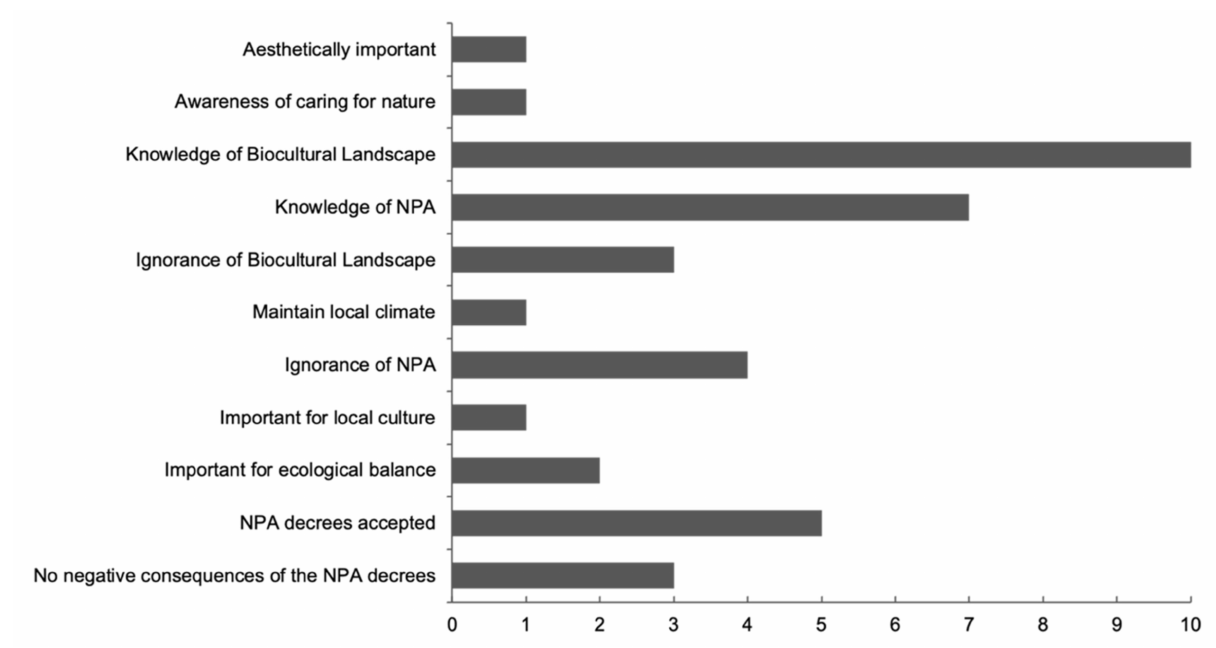
Figure 3. Frequency of responses by conservation and knowledge codes in protected areas